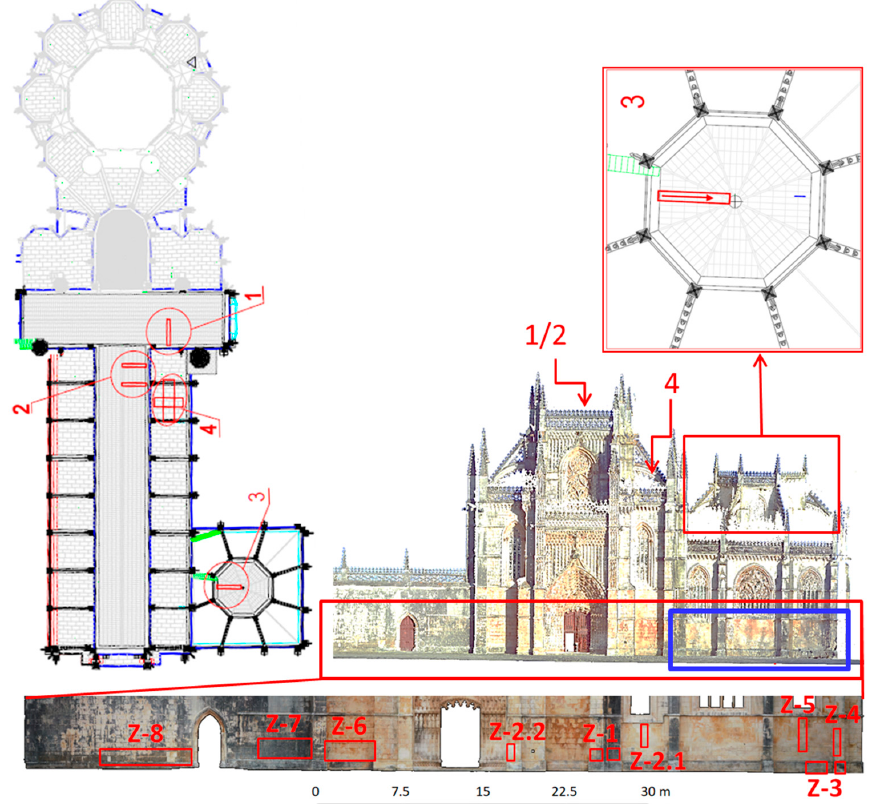
Figure 2. Orthoimage of the main façade of Monastery of Batalha (MB) with the zones prospected with ground-penetrating radar (GPR) (Z-7 and Z-8 correspond to the Royal Cloister, Z-1, Z-2.2, and Z-6 to the Church, and the remaining to the Founder’s Chapel). The plan views depict the roof zones surveyed on the Church—transept (1), nave (2) and right-hand aisle (4)—and on the central part of the Founder’s Chapel (3). The blue rectangle highlights the façade zone surveyed with infrared thermographic (IRT).